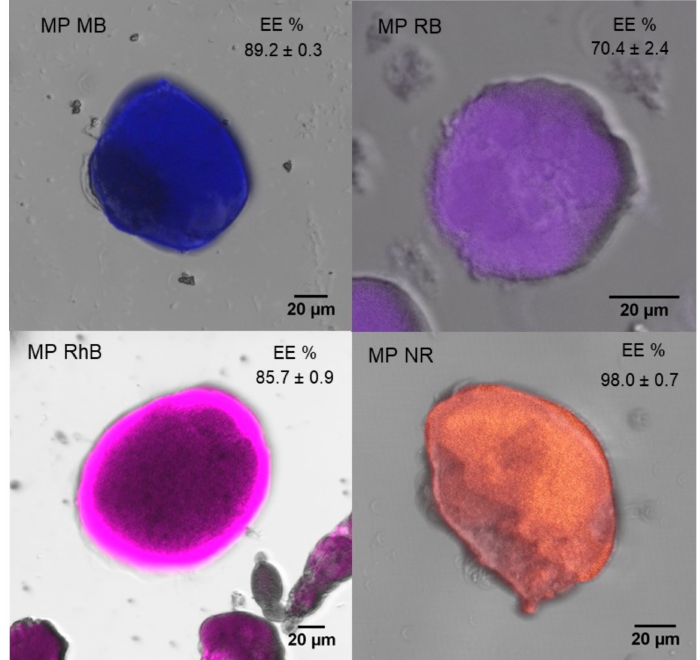
Figure 2. Confocal microscopy images of SF microparticles produced by the atomization method and loaded with dyes. The inset values represent the encapsulation efficiency of the